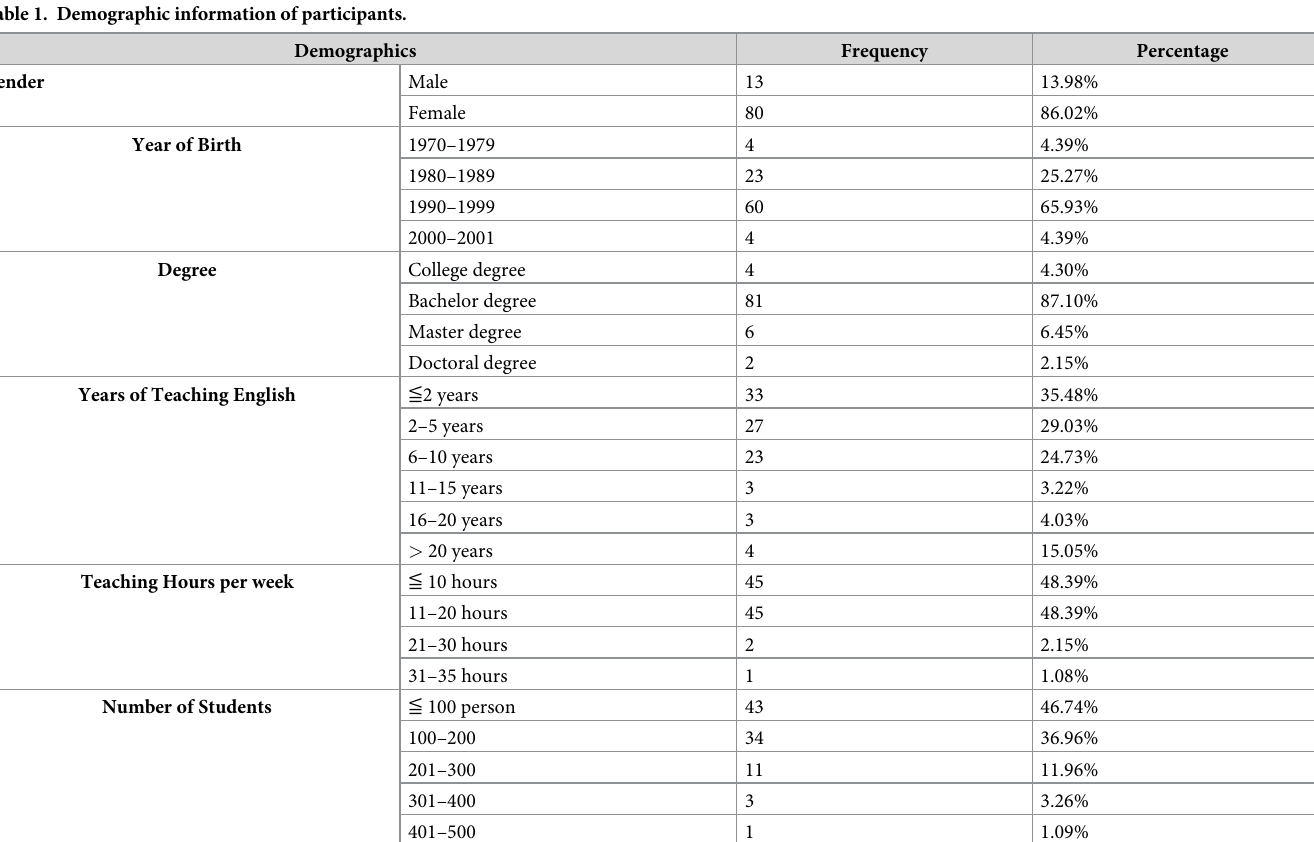
Table 1. Demographic information of participants.